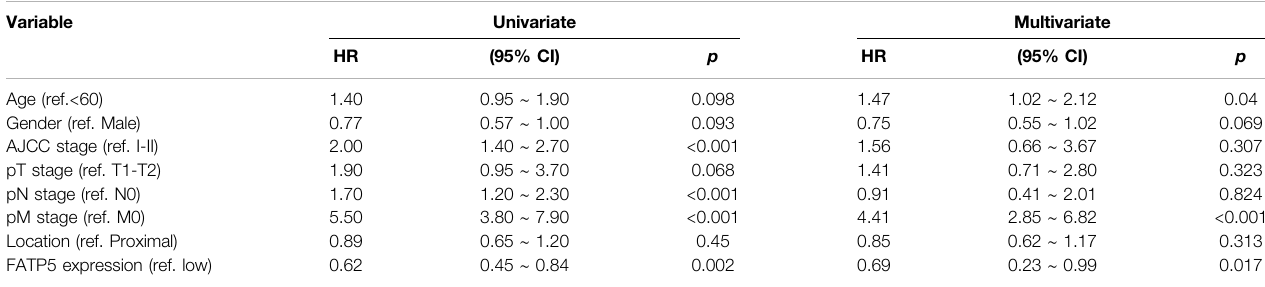
TABLE 3 | Univariate and multivariate regression analyses for predicting overall survival in GSE39582 cohort. Variable Univariate Multivariate HR (95% CI) p HR (95% CI) p Age (ref. <